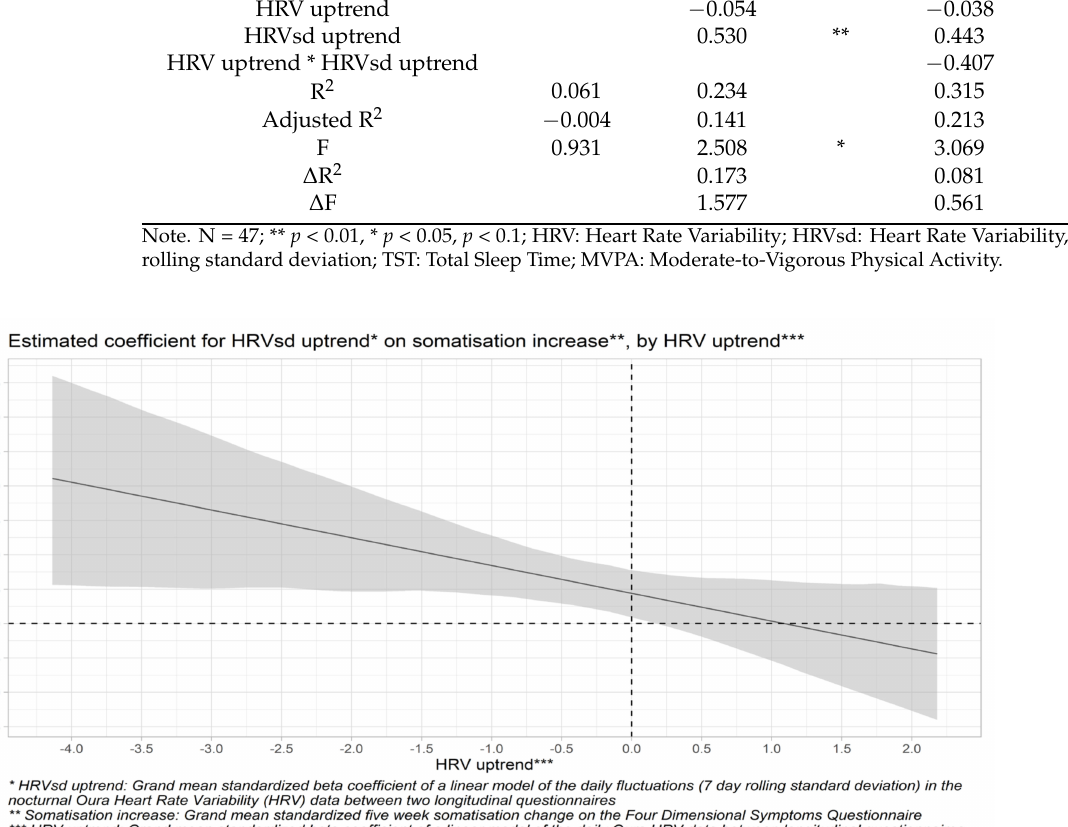
Figure 2. Estimated coefficient for the association between the five-week uptrend in the 7-day rolling standard deviation of the Heart Rate Variability (HRVsd) and five-week somatisation increase by the five-week HRV uptrend. The grey area represents the 95% confidence interval for the values that are estimated by the linear model (the thick black